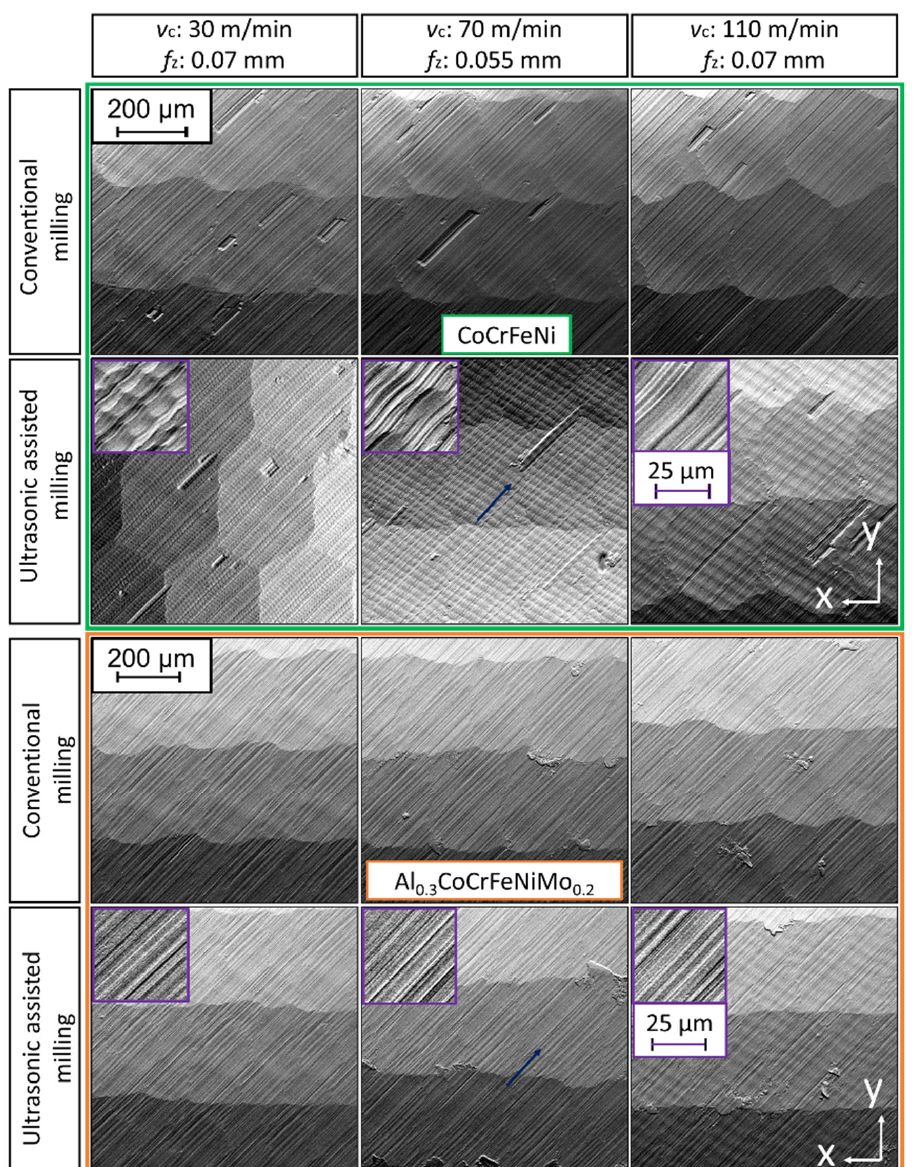
Figure 8. Topography EBS images of the milled surfaces for CoCrFeNi (upper green box) and Al 0.3 CoCrFeNiMo 0.2 (lower orange box) alloys for the different investigated milling conditions.